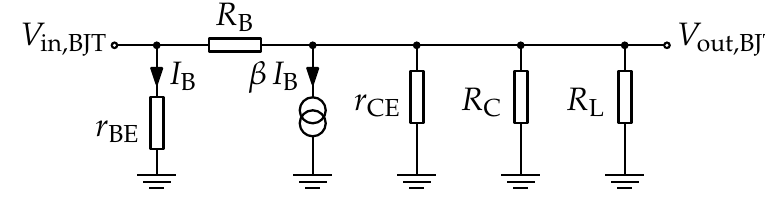
Figure 12. Small-signal circuit of the BJT amplifier according to